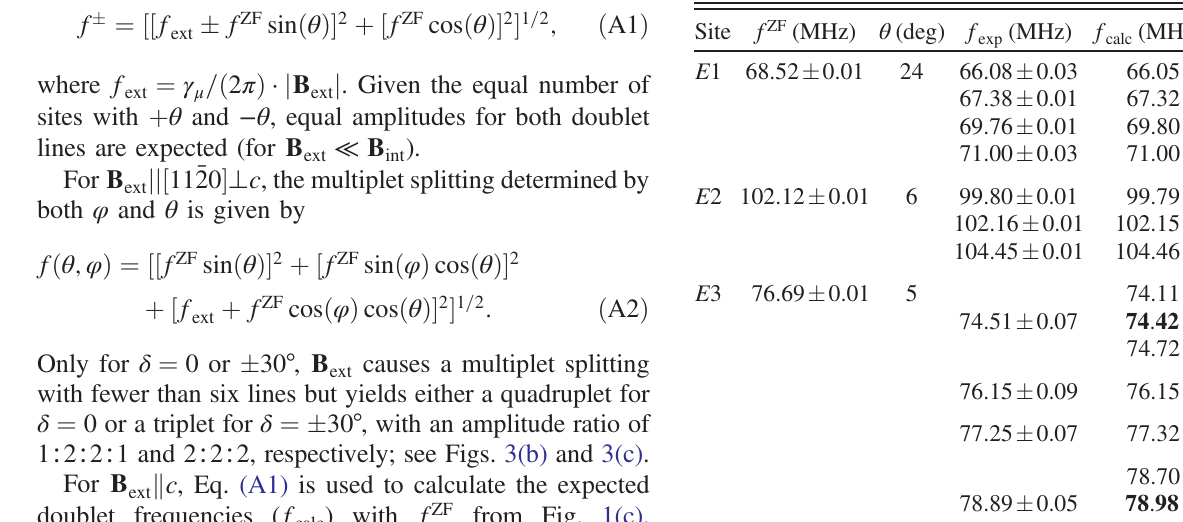
measured in C 1 at exp obtained with calc